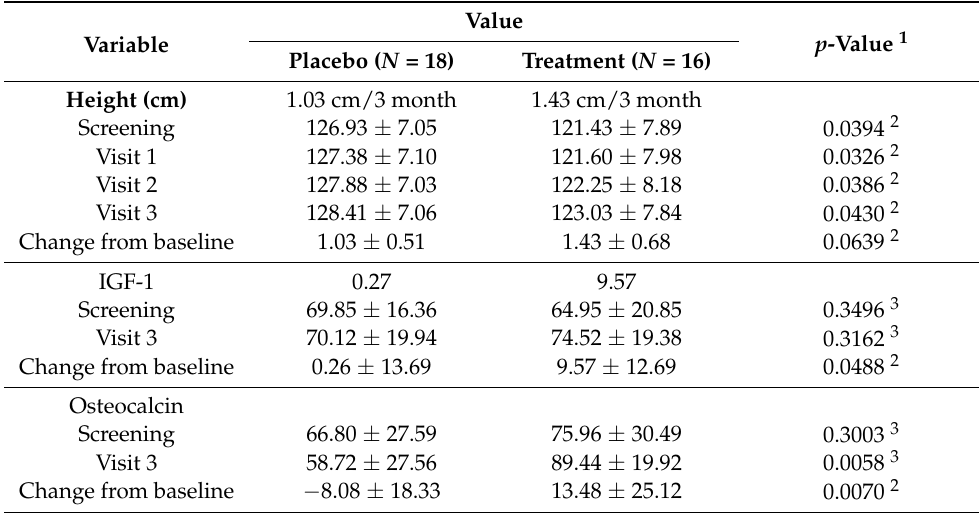
Table 4. Efficacy Comparison by treatment group at each assessment periods.